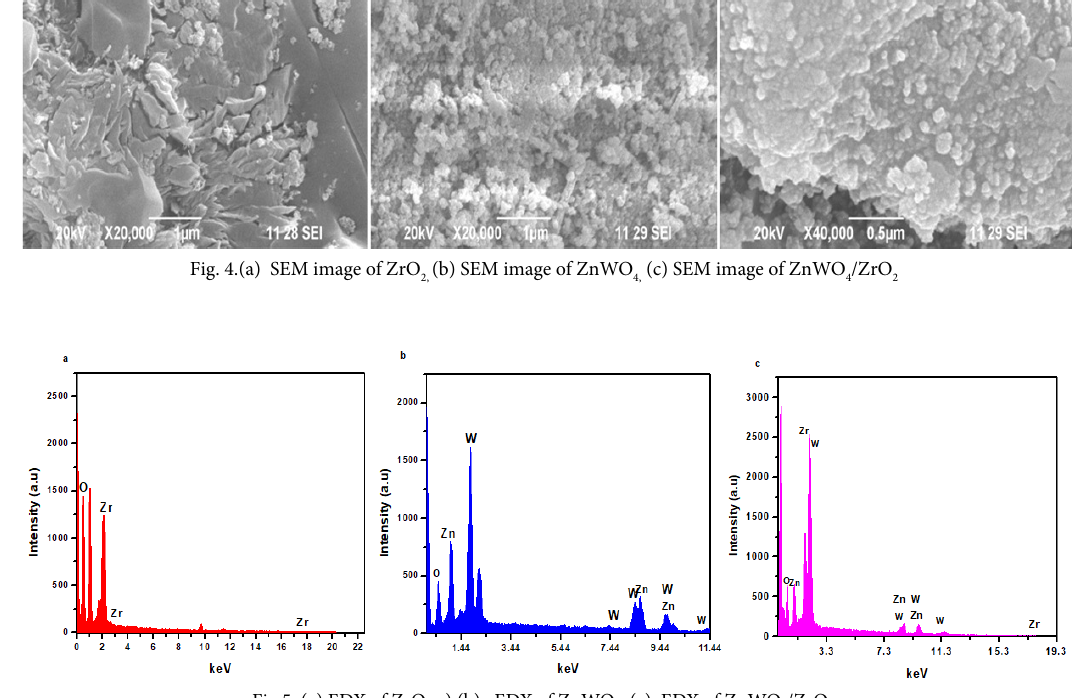
, ) (b) EDX of ZnWO 2